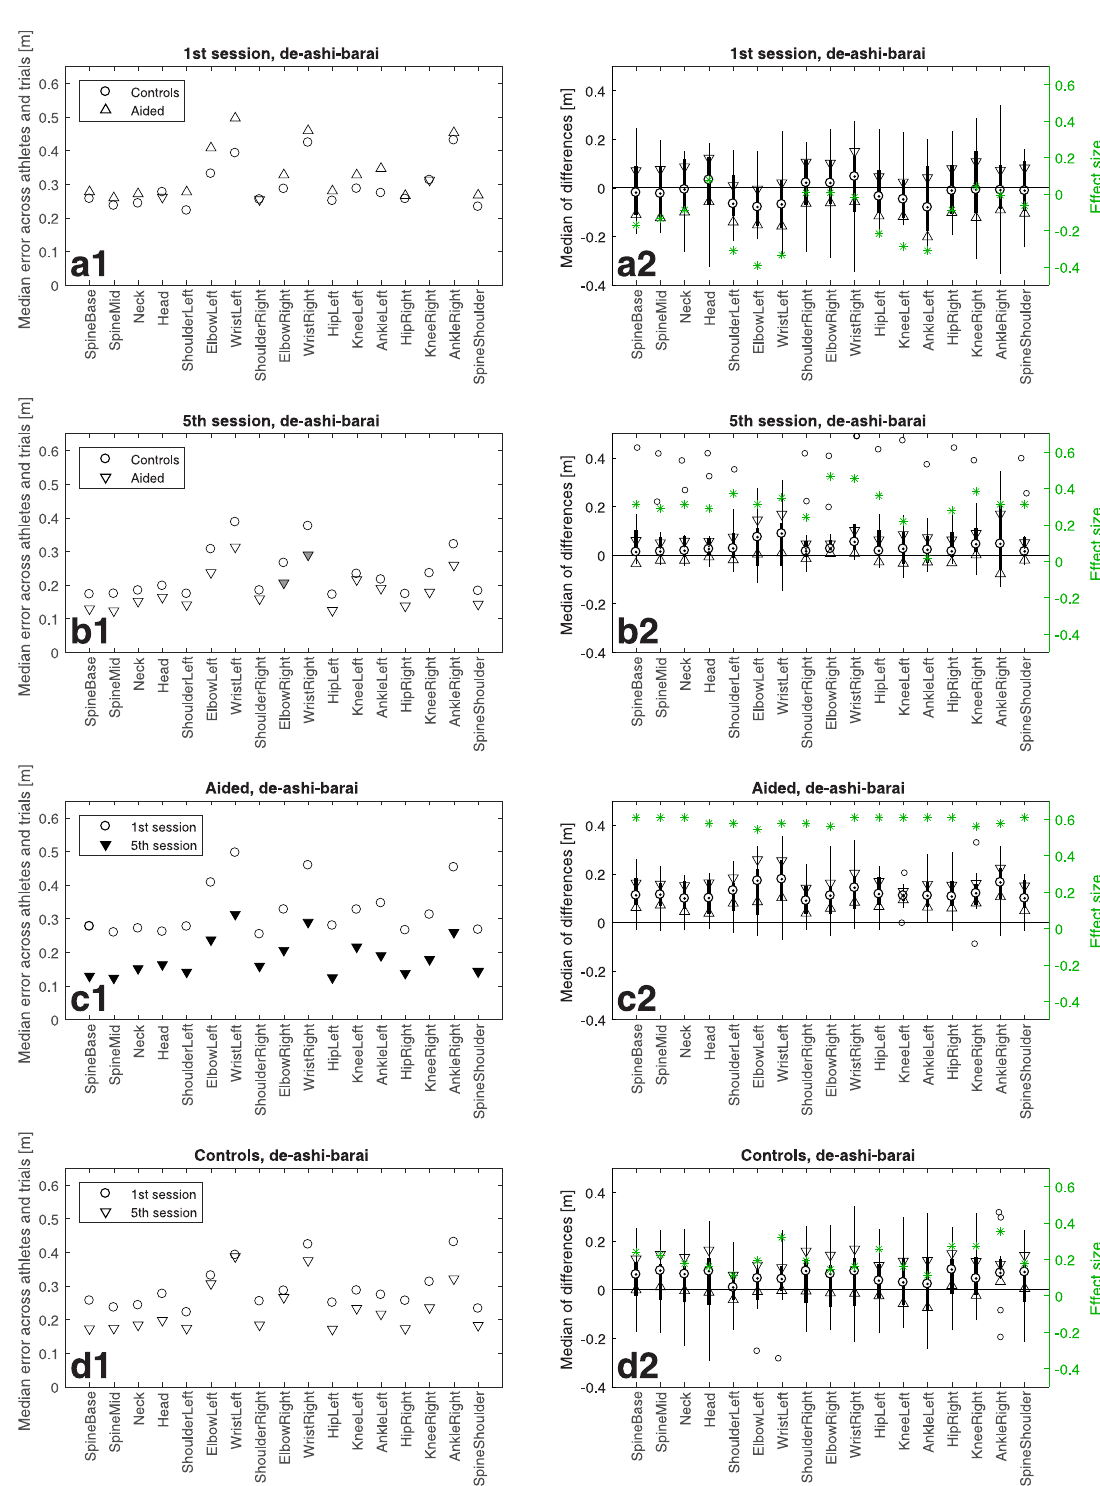
Fig 4. Results for de-ashi-barai . Panels in the left column show median error across athletes in a group and trials in a training session, in metres, with respect to the master performance for 17 body joints labelled along the horizontal axis. Consecutive rows show four types of comparisons: Aided vs Controls in the 1st and 5th session, the 1st vs 5th session for Aided and Controls; see legends. Solid triangles denote statistically significant differences with respect to the values represented by open circles, with grey and black triangles for p < 0.05